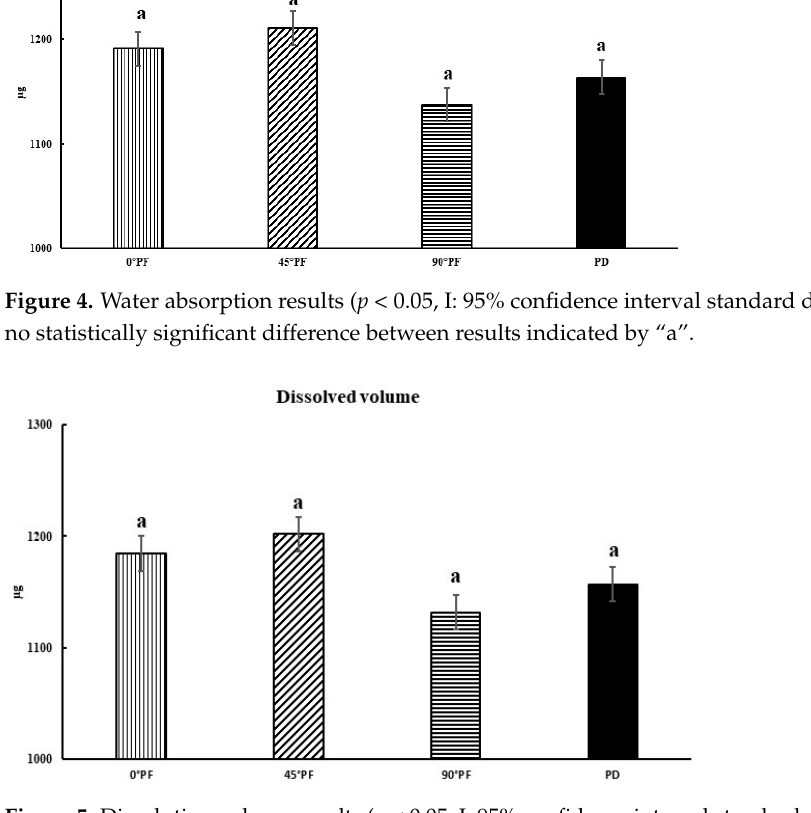
Figure 5. Dissolution volume results ( p < 0.05, I: 95% con fi dence interval standard deviation); there is no statistically signi fi cant di ff erence between results indicated by “a”.